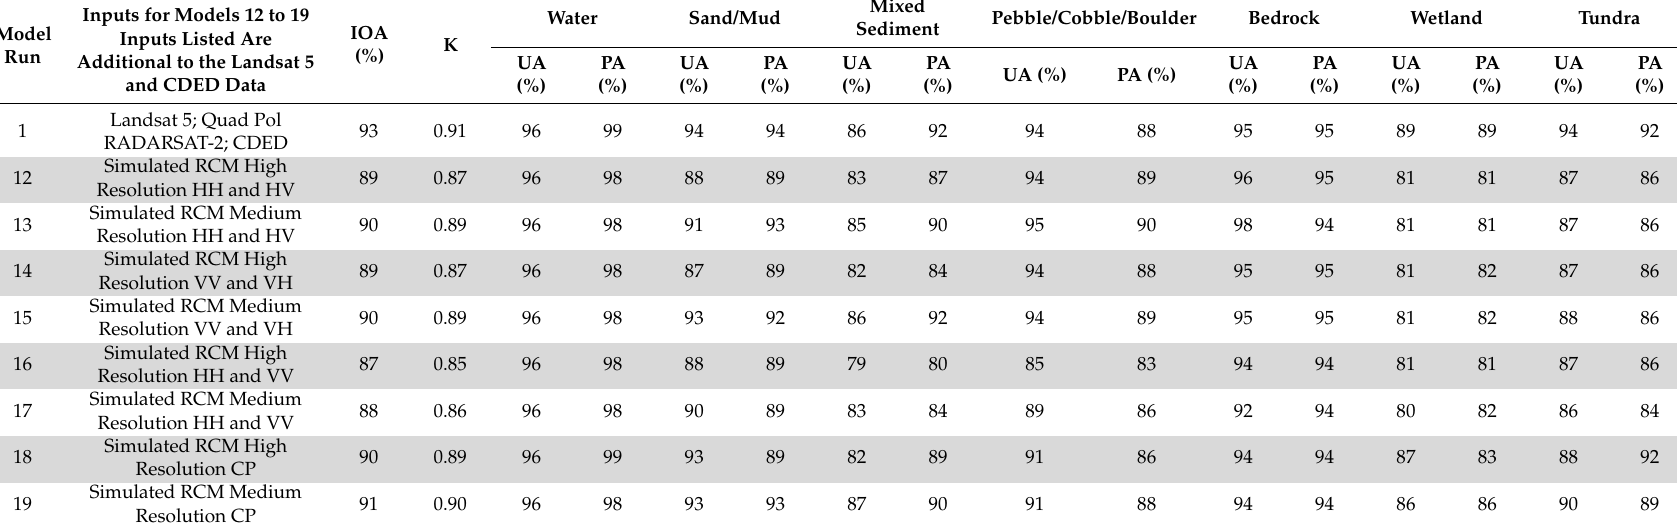
Table 12. Evaluation metrics, including: independent overall accuracy (IOA), Kappa statistic values (K), and per-class user’s and producer’s accuracies (UA and PA) for Random Forest models generated with simulated RCM, Landsat 5, and CDED data. For comparison, results are included for the Random Forest model based on all Landsat 5, quad pol RADARSAT-2 and CDED